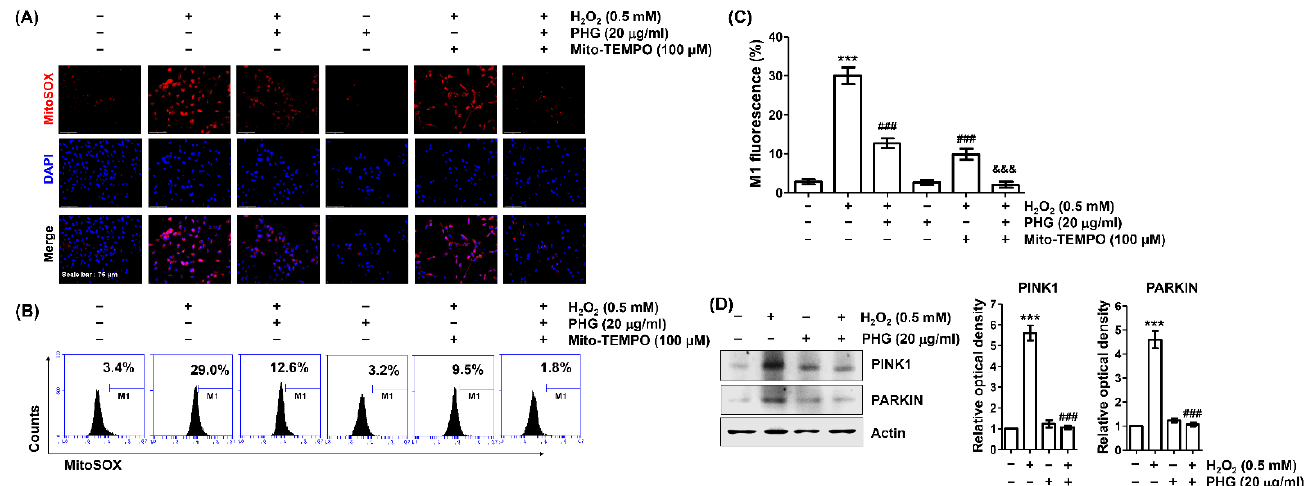
Figure 5. Phloroglucinol eliminates H 2 O 2 -mediated mtROS generation in ARPE-19 cells. MitoSOX staining was performed to determine the abundance of mtROS in cells treated with H 2 O 2 for 24 h after pretreatment for 1 h with or without phloroglucinol and/or Mito-TEMPO. ( A ) Representative images of cells stained for mitochondrial peroxide (MitoSOX, red) and nuclei (4’,6-diamidino-2- phenylindol, DAPI, blue) are shown. ( B , C ) For quantitative evaluation of mtROS production, flow cytometric analysis was performed. Representative histograms ( B ) and average values ( C ) are shown. ( D ) Isolated total cell lysates were immunoblotted with antibodies corresponding to indicated mitophagy-marker proteins. (*** p < 0.001 vs. unstimulated control; ### p < 0.001 vs. H 2 O 2 alone treatment; &&& p < 0.001 vs. phloroglucinol + Mito-TEMPO